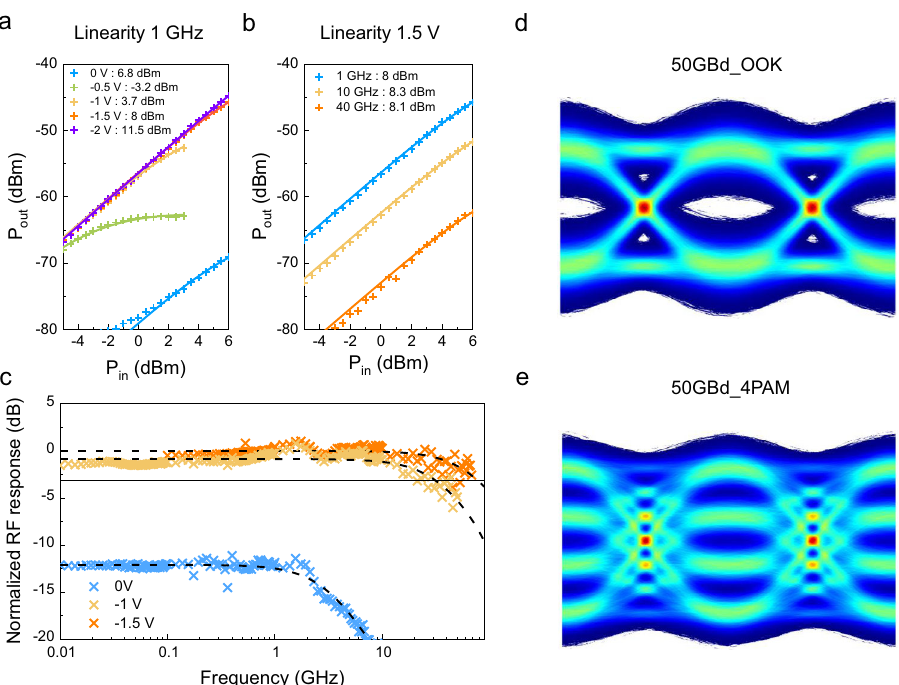
Fig. 6 Linearity and dynamic characterization of the photodetectors. a Linearity at 1 GHz measured on device T2 at different reverse bias voltages, showing output power (P out ) vs input power (P in ). b Linearity at a constant 1.5 V reverse bias measured on device T2 for different small-signal frequencies. c Radio frequency (RF) signal response dependence on modulation frequency of the input signal measured on device T3. d 50 GBd OOK eye diagram measured on device T3. e 50 GBd 4PAM eye diagram measured on